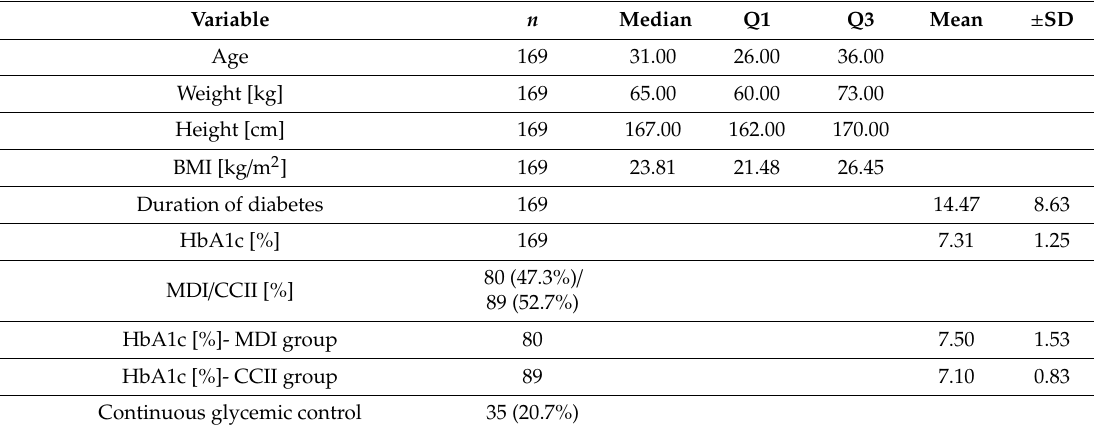
Table 2. Clinical and biochemical characteristics of the studied